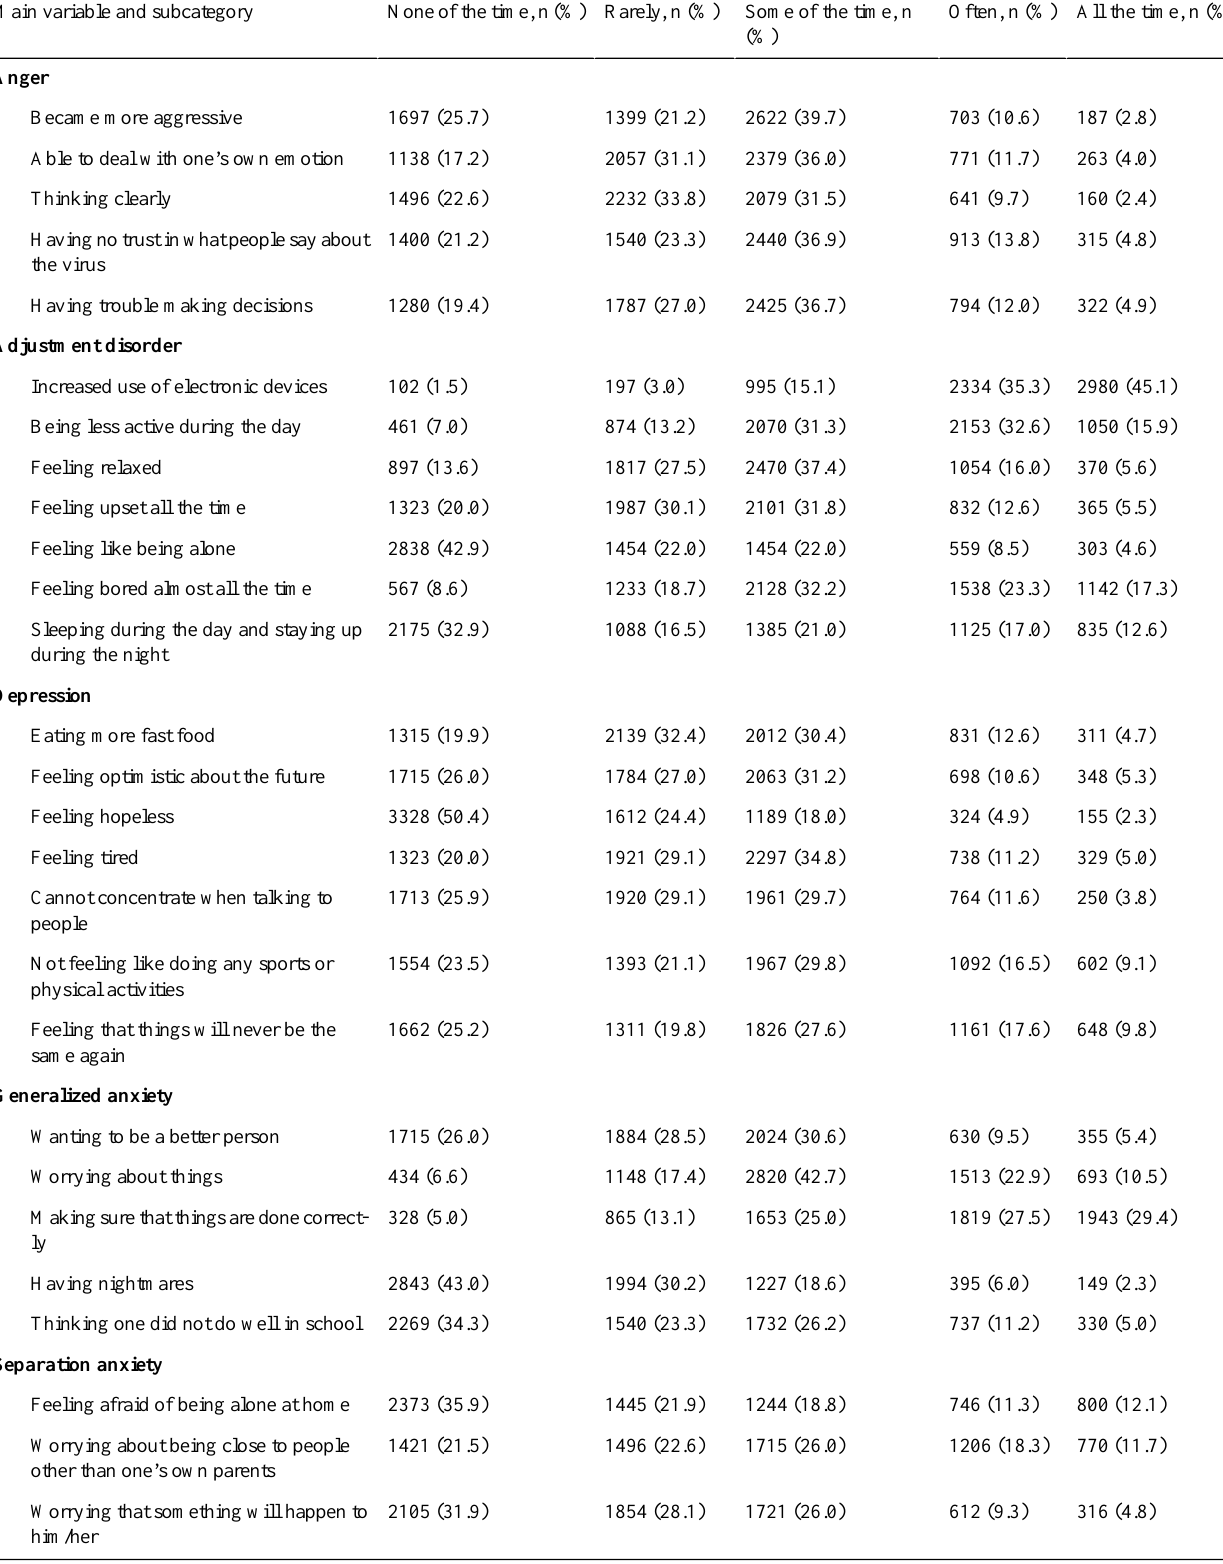
Table 2. Frequency distribution of symptoms related to each final psychological diagnosis among children and adolescents during home isolation and social distancing due to the COVID-19 pandemic in Qatar in 2020